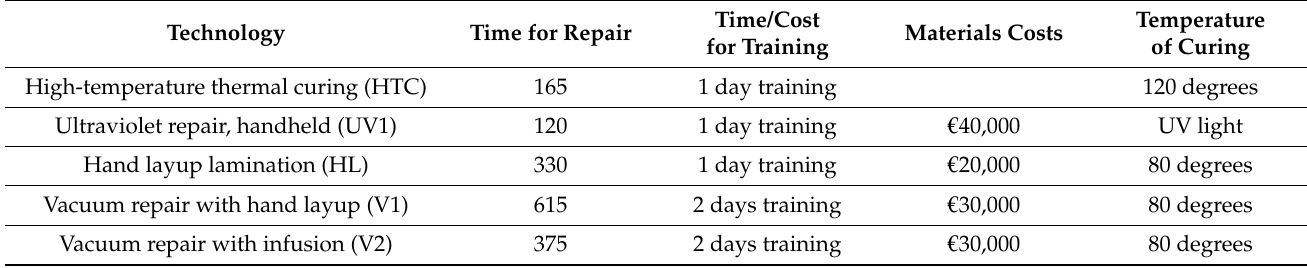
Table 1. Evaluations of efforts of different repair technologies made by technician team.